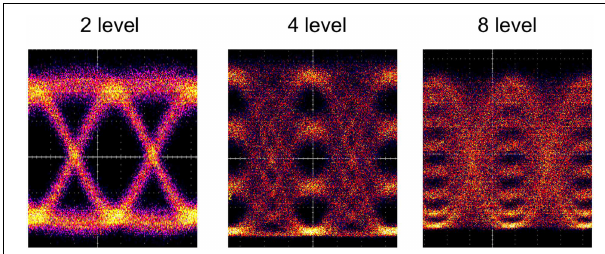
FIGURE 16 | Measured PAM-2, -4, and -8 optical eye diagrams at 28 Gbaud using a silicon photonics modulator.